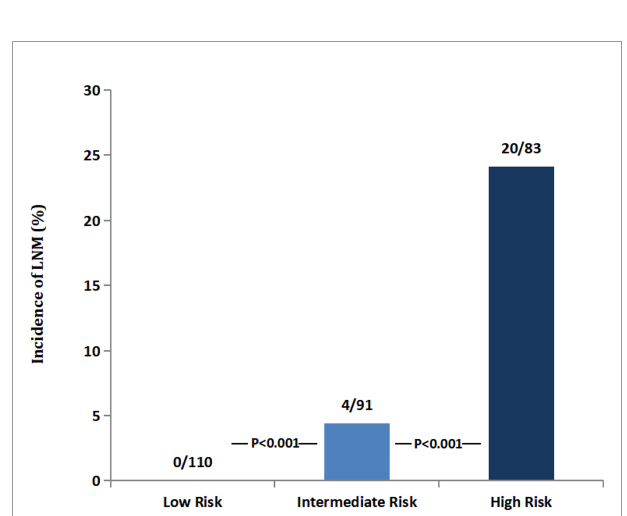
FIGURE 3 | The number of LNM according to RPA risk strati fi cations.